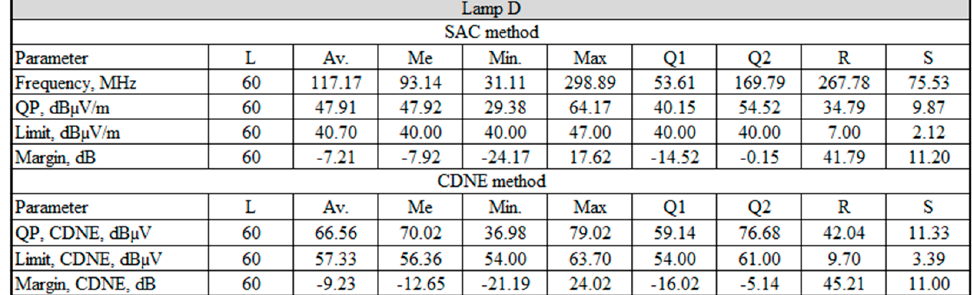
Figure 14. Recorded QP values using the new and traditional method against the allowable limits for the 18 W LED lamp D under test, where: L—number of analysed values, AV—calculated average value, Min, Max—minimum and maximum values, Q1, Me(Q2), Q3—first, second and third quartile, R—range, S—standard deviation.